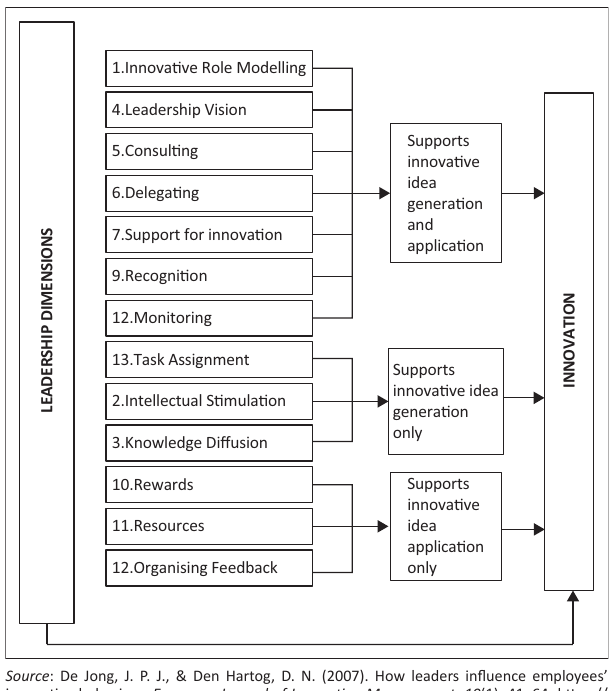
FIGURE 1: De Jong and Den Hartog’s (2007) conceptual framework for stimulating